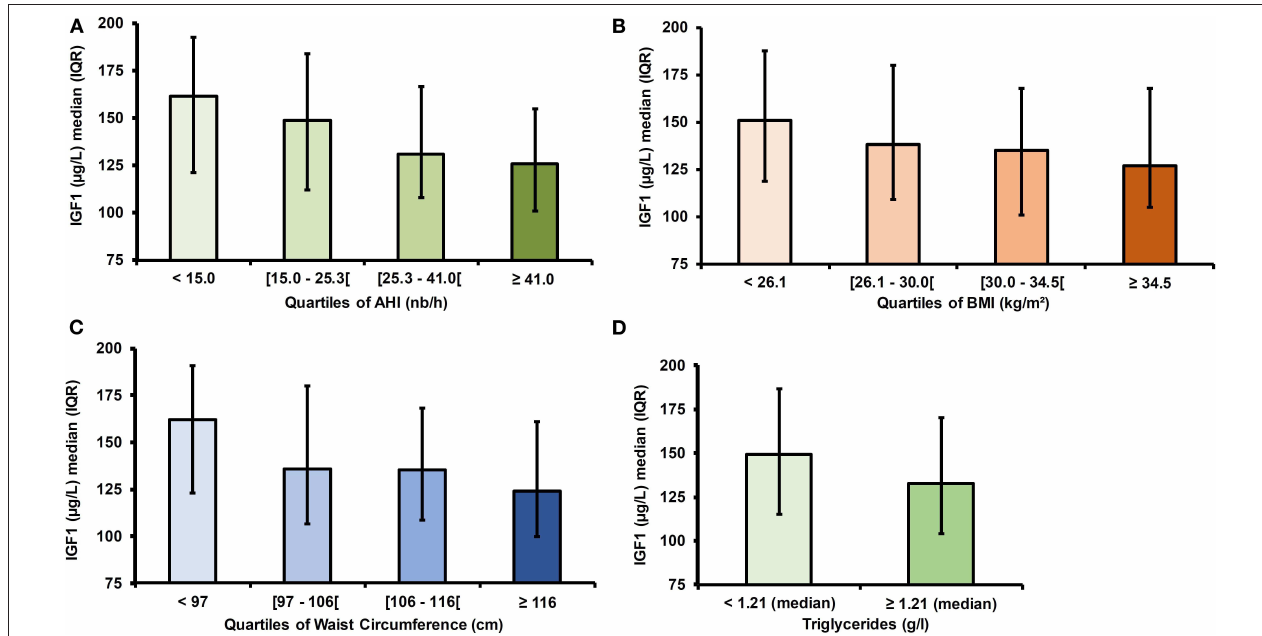
FIGURE 1 | IGF -1 levels according to abdominal obesity and obstructive sleep apnea severity. (A) IGF-1 levels according to AHI quartiles. (B) IGF-1 levels according to BMI quartiles. (C) IGF-1 levels according to waist circumference quartiles. (D) IGF-1 levels according to triglyceride levels. IGF-1, Insulin Growth factor 1; AHI, Apnea Hypopnea Index; OR, Odds Ratio; IQR, interquartile range.